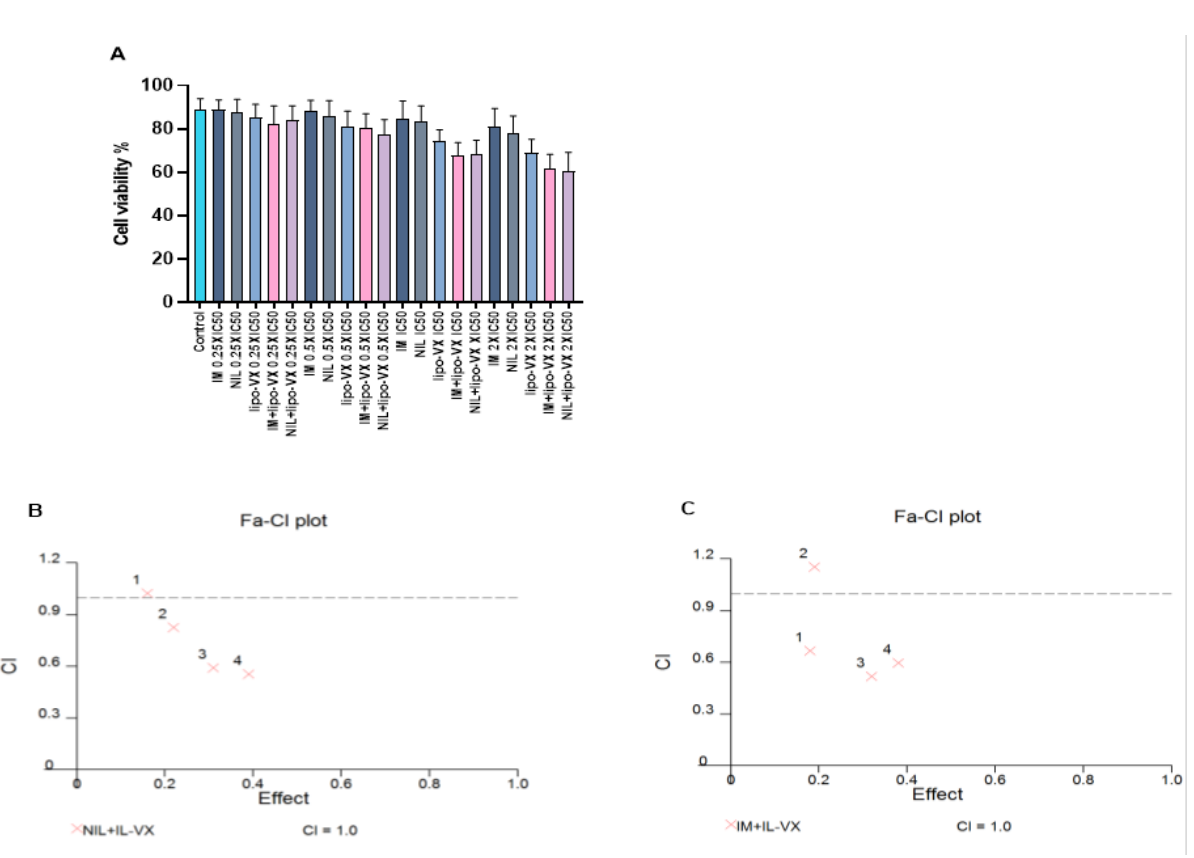
Figure 6. Combination treatment of IL-VX with imatinib and nilotinib. Treatment of CMLT1 with IL-VX, NIL, IM, and a combination of IL-VX with NIL and IL-VX with IM was performed based on their IC50 ( A ). As is displayed in ( B ) the combination of 0.50 × IC50, IC50, and 2 × IC50 of IL-VX and NIL had a synergistic effect and we had also synergistic effect between IL-VX and IM in 0.25 × IC50, IC50, 2 × IC50 ( C ). Synergistic effect (CI < 1), additive effect (CI = 1), antagonistic effect (CI > 1).